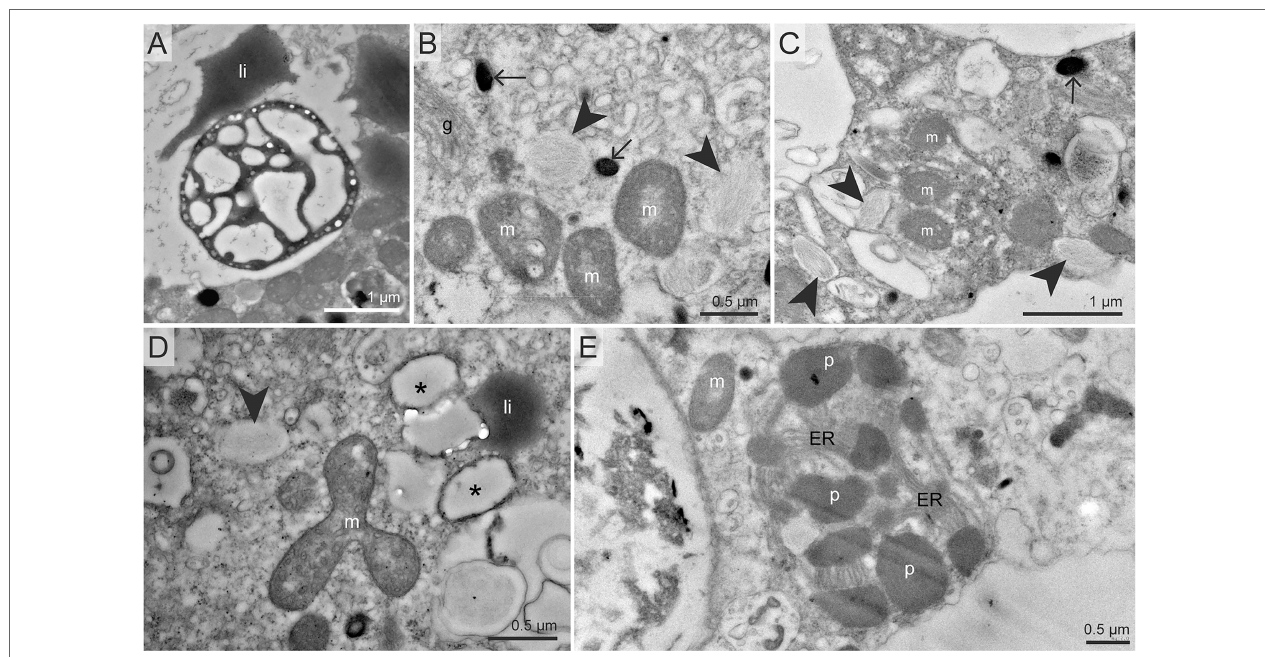
FIGURE 2 | TEM micrographs of organelles commonly found 15 N- or 34 S-enriched in our benthic foraminiferal cells after incubation with 15 N-ammonium and/or 34 S-sulfate. (A) Close-up of a putative prokaryote-like structure observed in B marginata endoplasm in inset 1 of Figure 1 . (B, C) Electron opaque bodies and fibrillar vesicles, two structures commonly found enriched in 15 N and 34 S, here in N. turgida (B) and N. labradorica Gullmar fjord (C) . (D) 34 S-enriched vesicles with thick membranes observed in E williamsoni . (E) Peroxisome – endoplasmic reticulum (P-ER) complex in Globobulimina pacifica . Arrows: electron-opaque bodies, arrowheads: fibrillar vesicles, asterisks: thick-membrane vesicles, li, lipid droplets; m, mitochondria; p,